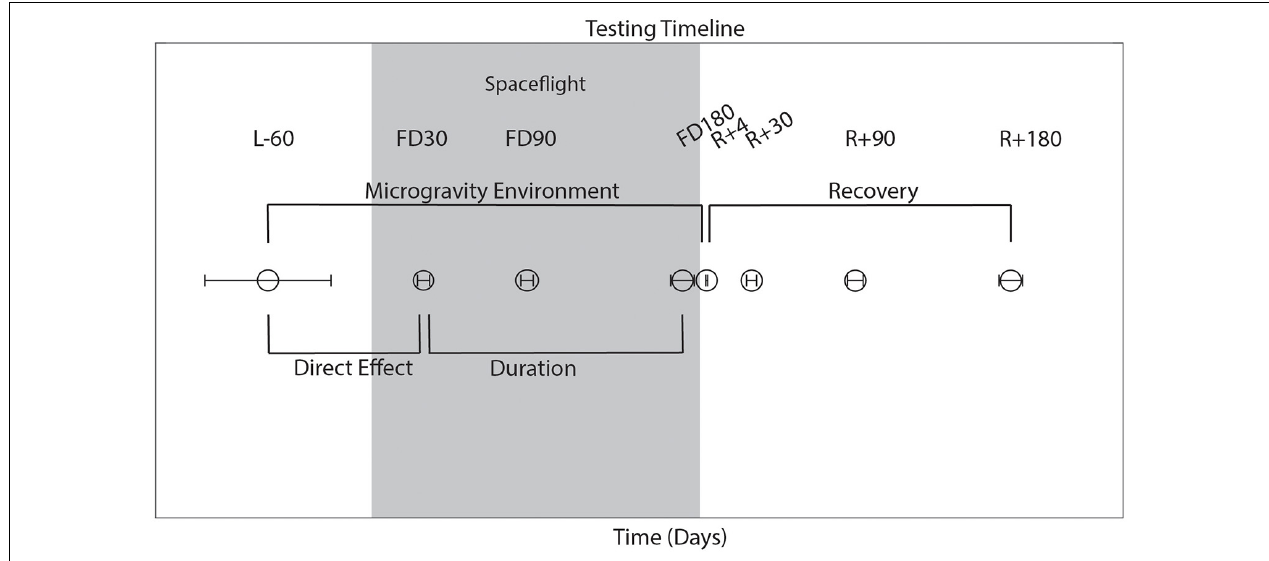
FIGURE 1 | Testing timeline. L, launch; R, return; FD, flight day, time spent during spaceflight. Launch occurred on day 0. The average day of data collection is plotted relative to launch, with error bars indicating standard